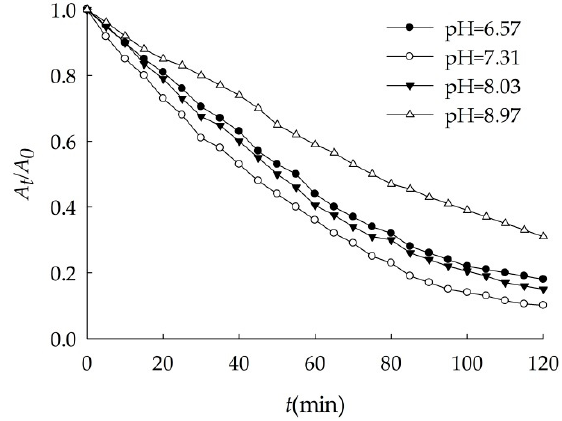
Figure 4. Effects of pH on the sedimentation of nano-Al 2 O 3 ( S = 31.5).